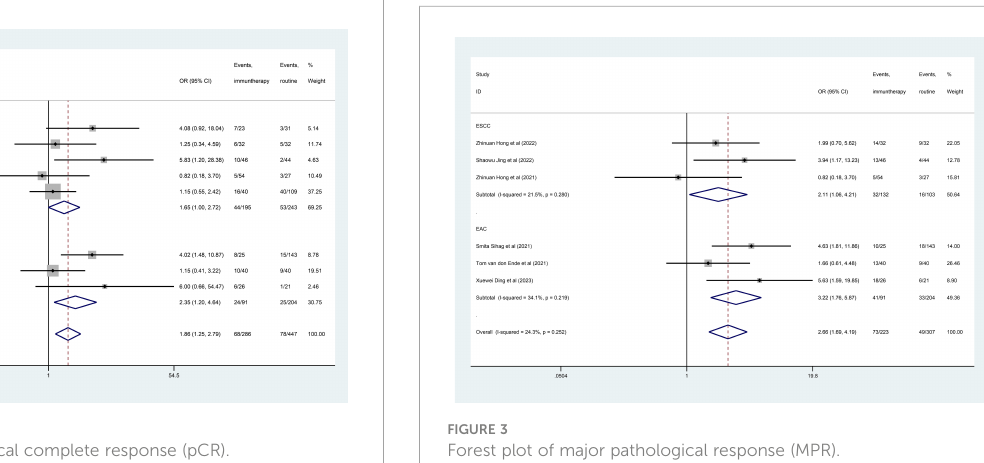
FIGURE 2 Forest plot of pathological complete response (pCR).